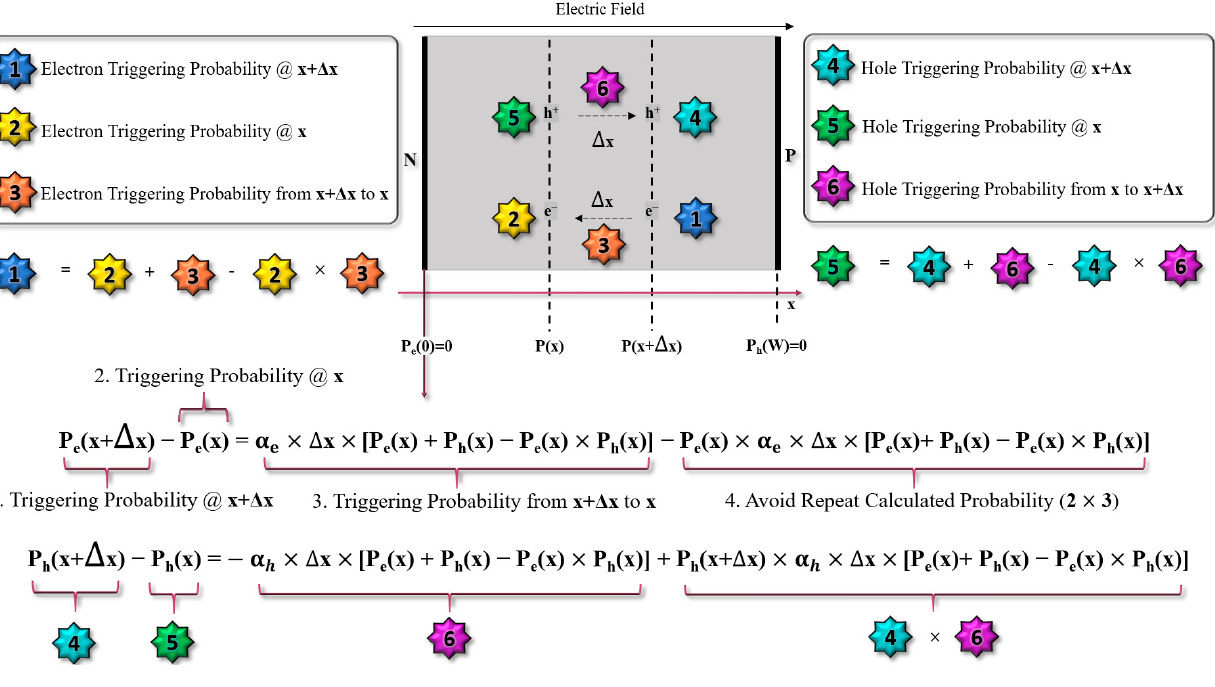
Figure 4. Triggering probability diagram.